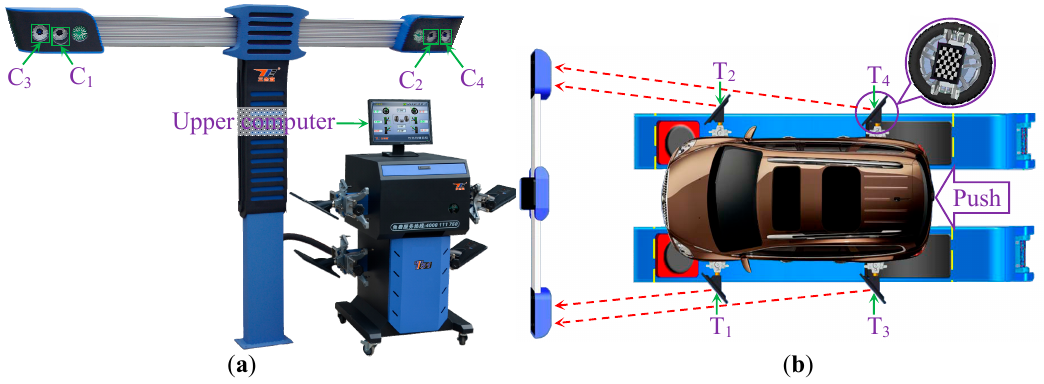
Figure 16. 3D four-wheel alignment. ( a ) System composition. ( b ) Initial operation.